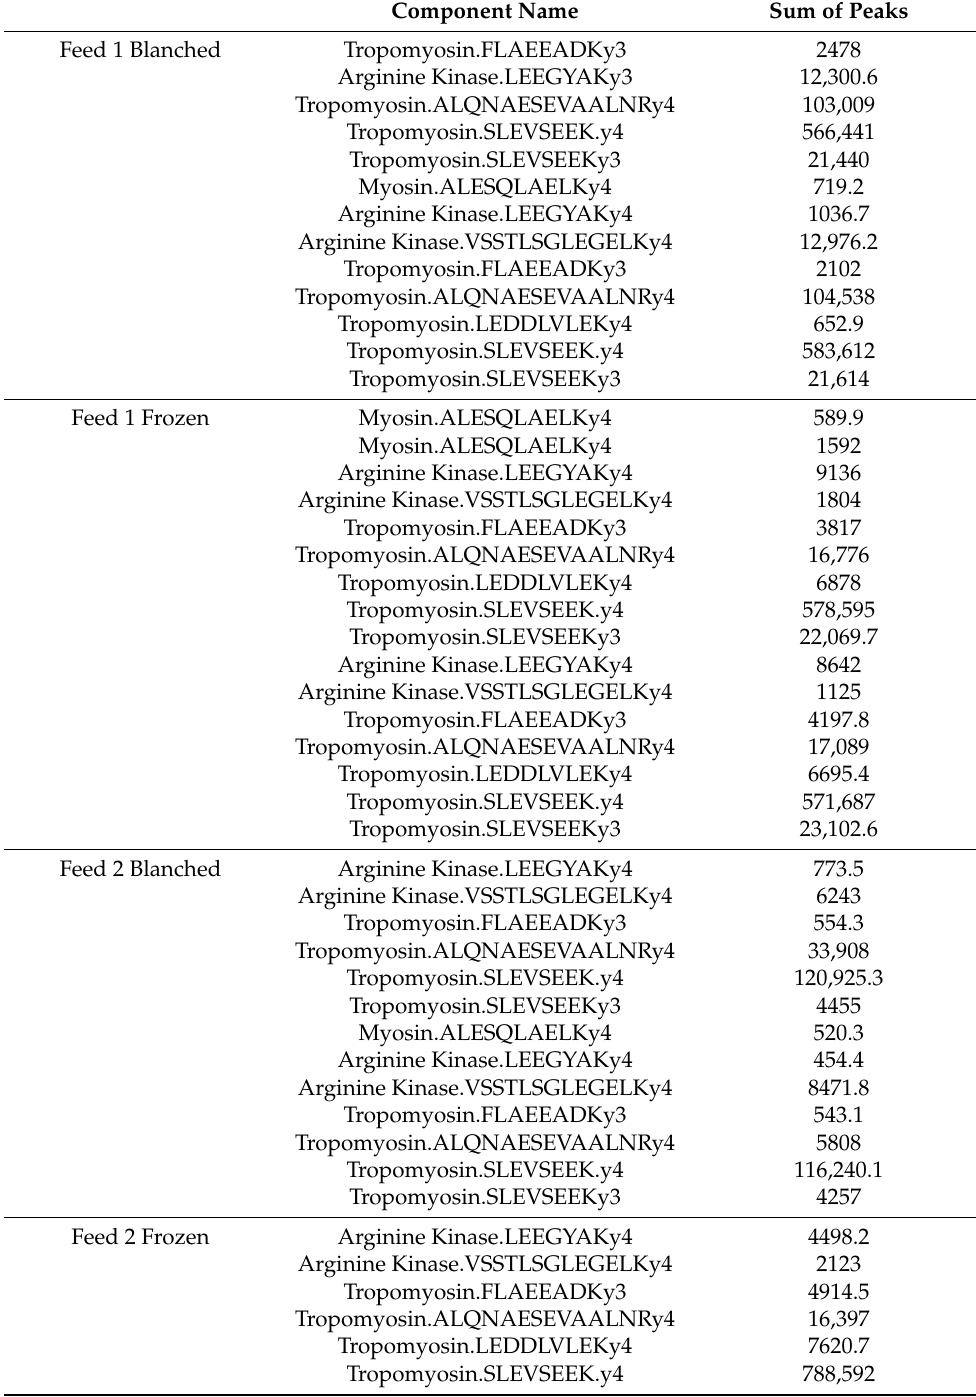
Table A1. Three common cross-reactive crustacean allergenic peptides which presented a positive hit in the liquid chromatography mass spectrometry (LS-MS). The in-silico assessment was carried out using cRAP contaminant database on black soldier fly peptides